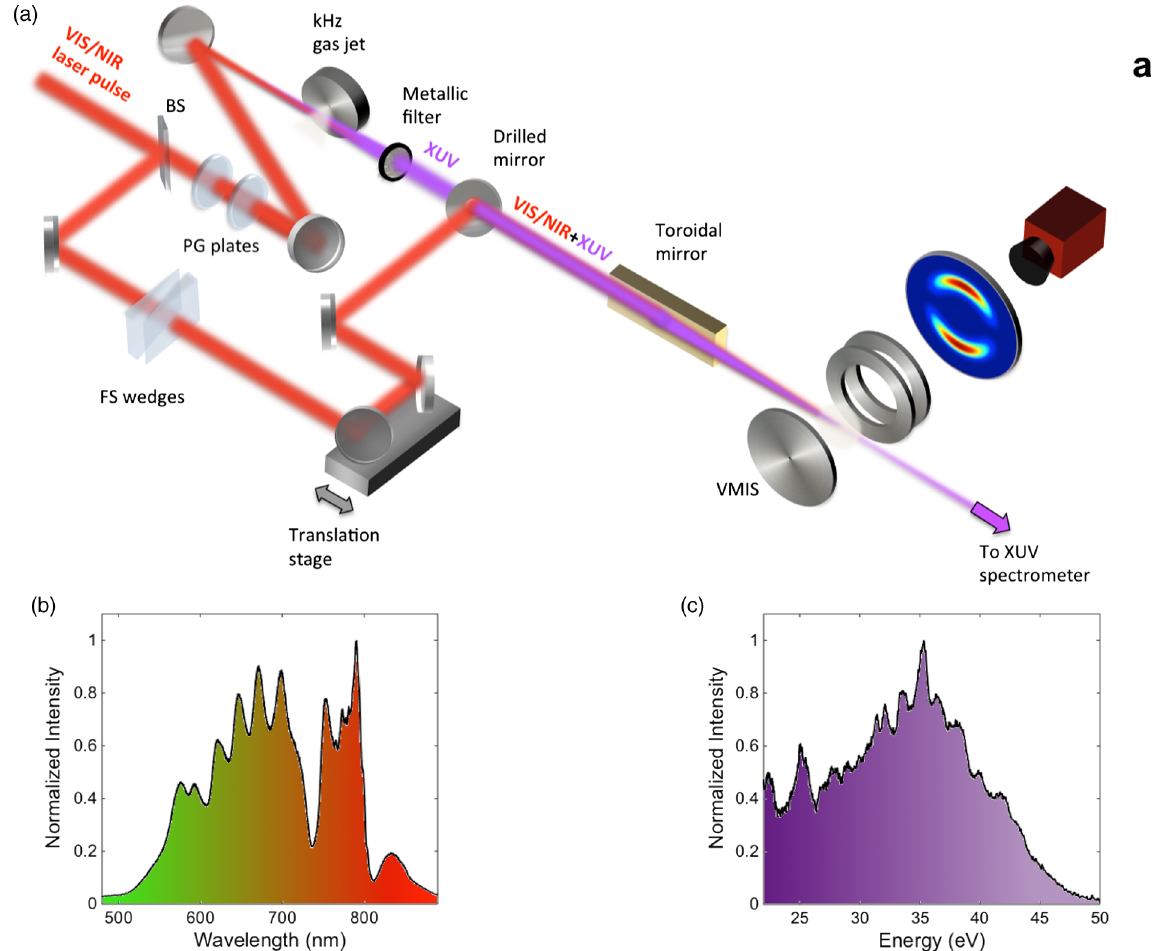
FIG. 10. (a) Scheme of the experimental setup. In the figure, BS is used for Beam Splitter, FS wedges is used for Fused Silica wedges, PG plates is used for Polarization Gating plates and VMIS is used for Velocity Map Imaging Spectrometer. Acquired spectrum of the NIR/VIS (b) and XUV (c)